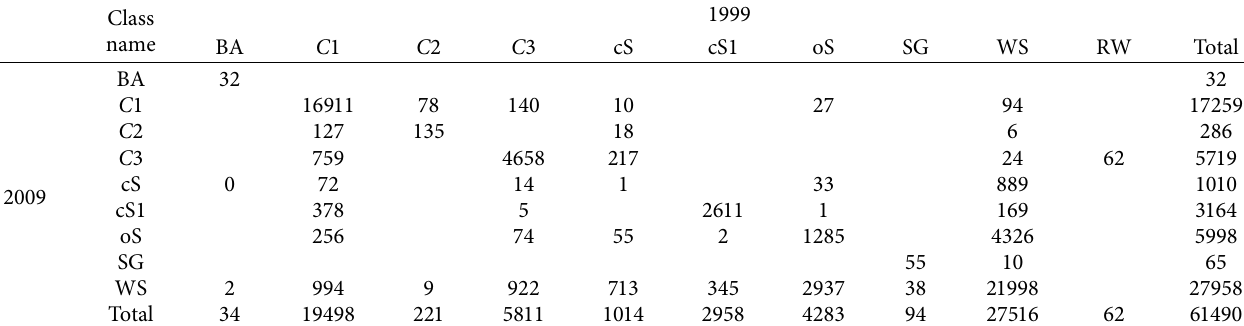
Table 5: LULC change matrix for the period 1999–2009 by hectares.